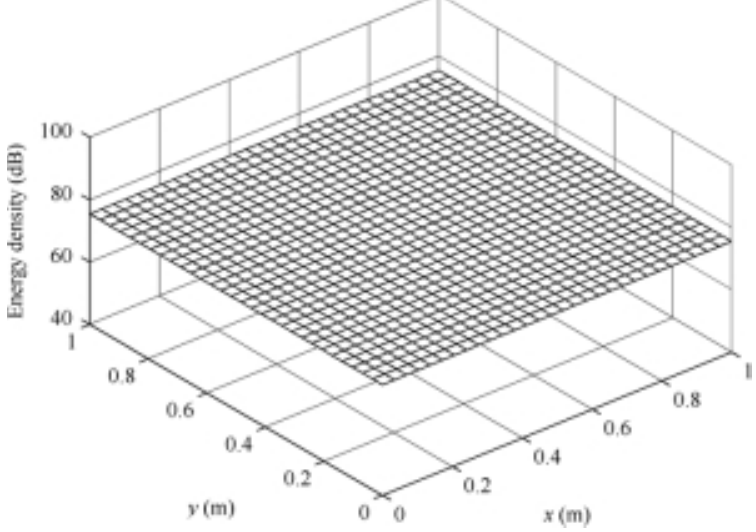
Fig. 4. The approximate energy density distribution of the orthotropic plate when f = 500 Hz and η = 0 . 02 . The reference energy density is 1 × 10 − 12 J/m 2